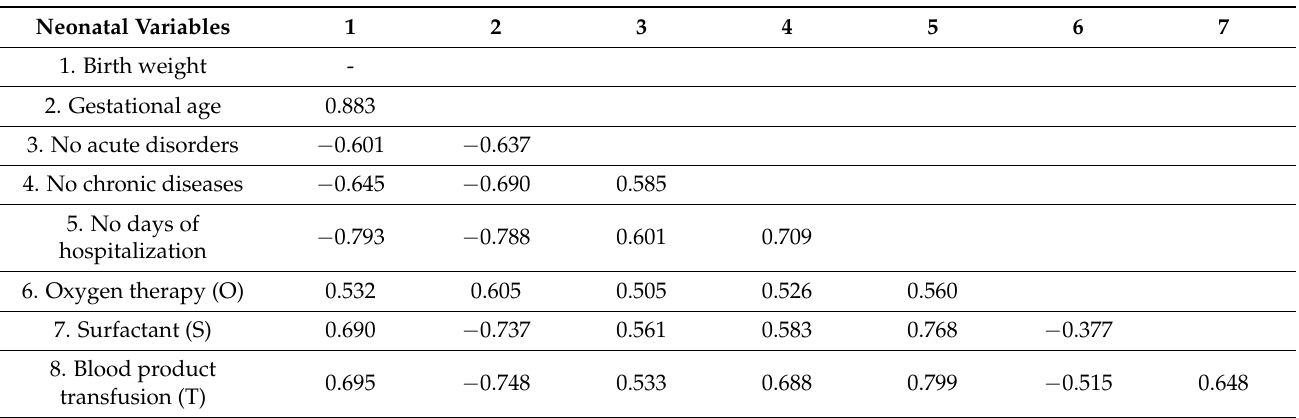
Table 2. Correlations between neonatal variables.